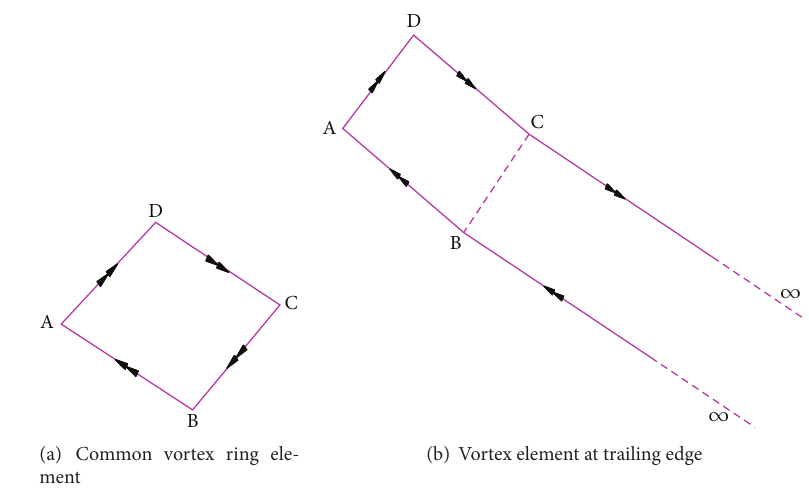
Figure 3: Typical vortex elements.